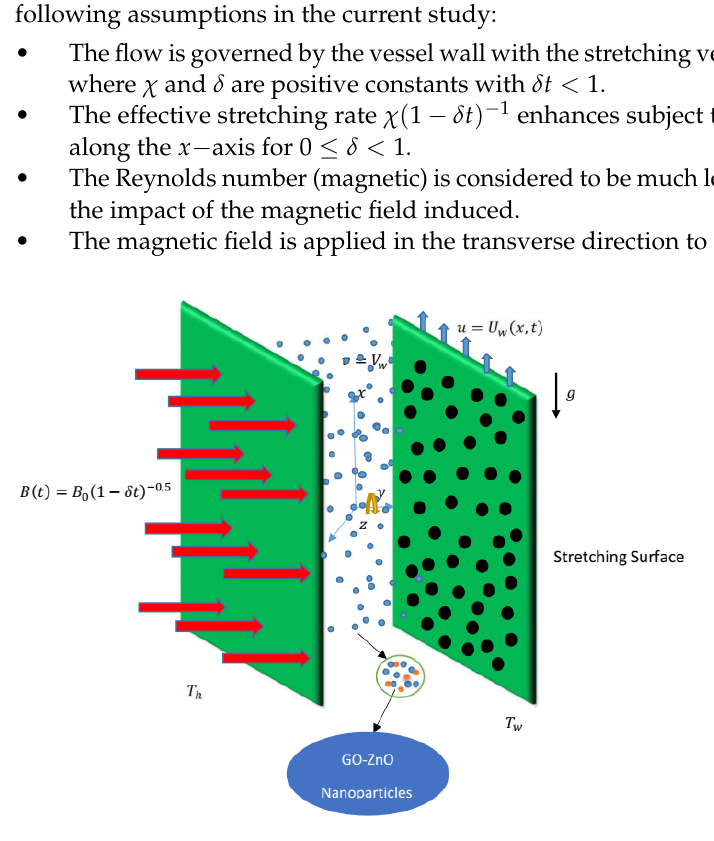
Figure 1. Geometrical display of the undertaken